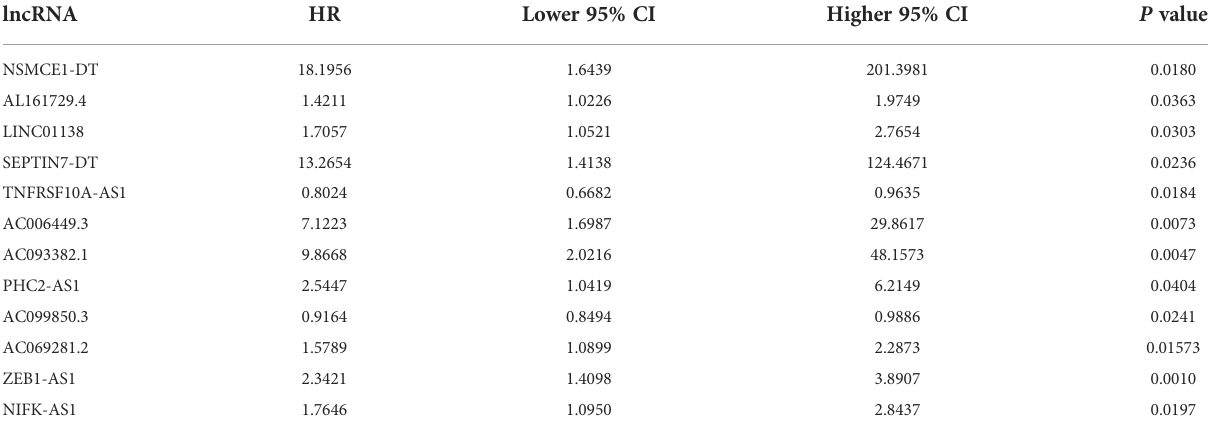
TABLE 1 Univariate Cox analysis generated 12 CRLs that are signi fi cantly related to the overall survival (OS). lncRNA HR Lower 95%